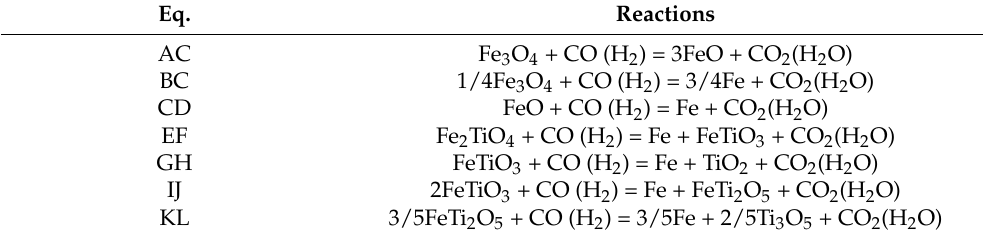
Table 5. Main reactions of reducing iron and titanium oxides by H 2 and CO. Eq.